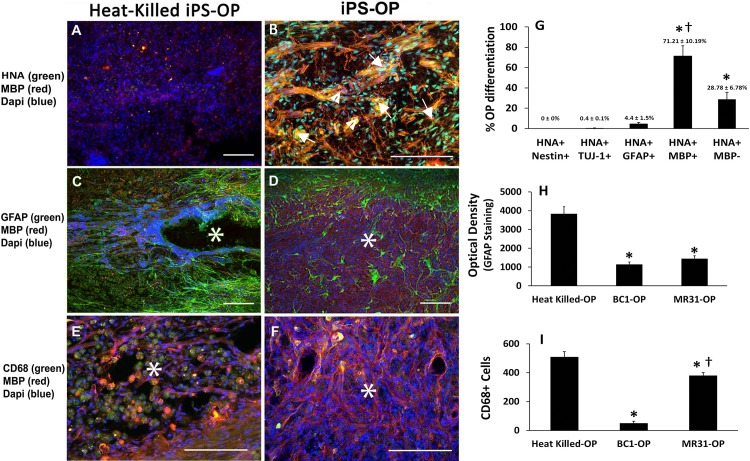
Immunohistological characterization in rat spinal cords at the epicenter of injury (asterisks) following transplantation of either (A) heat-killed iPS-OPs or (B) live iPS-OPs, 24 hours after injury.Human specific anti-nuclei antibody (HNA) staining showed that cells transplanted at the site of injury could survive, differentiate and express myelin basic protein (MBP, red) in iPS-OPs group, compared to the heat-killed iPS-OPs group. (C) Heat-killed iPS-OPs treated spinal cords demonstrated more cavitation and higher glial fibrillary acidic protein (GFAP) (green) expression than (D) spinal cords treated with iPS-OPs. Heat-killed iPS-OPs also expressed less MBP, a mature oligodendrocyte marker, than live iPS-OPs (red). (E) Double immunostaining with CD68 (expressed by macrophages, microglial, and T cells) and MBP shows more CD68+/MBP+ cells in control animals with morphology indicative of active macrophages or microglial engulfment of OPs. (F) Spinal cords injected with iPS-OPs had significantly fewer CD68+/MBP+ cells. Tissues shown here were isolated approximately 2 months after transplantation. DAPI was used to stain rat and human nuclei (blue). Scale bars for A, C, D: 100 μm and B, E, F: 30 μm. (G) Quantitative image analysis shows that more than 70% of HNA+ cells were differentiated MBP+ oligodendrocytes. Only 4.4 ± 1.5% of grafted cells express glial fibrillary acidic protein (GFAP), while no HNA+ cells were detected with co-localized staining for neuronal marker neuron-specific class III beta-tubulin (TUJ1) or NESTIN. Values represent mean ± SEM. * denote statistical significance of human MBP+ oligodendrocytes and MBP- OPs compared to either human-derived neural progenitors (Nestin+), neurons (TUJ1+) or astrocytes (GFAP+) and † denotes statistical significance of human HNA+MBP+ compared to HNA+MBP- OPs by Tukey post hoc tests. Tissue slices encompassing the injury epicenter were stained in intervals for each antibody combination from 4 rats in each treatment group, P < 0.001). (H) Optical density quantification of GFAP staining, which shows significantly higher intensity of GFAP staining in heat-killed iPS-OP compared with iPS-OPs of both BC1 and MR31 lines. (I) Quantification of the number of CD68+ cells shows significantly higher CD68+ cells in heat-killed iPS-OPs, indicative of increased inflammation and macrophage activation, compared with iPS-OPs of both BC1 and MR31 lines. Values in the graphs represent mean ± SEM. * and † denote statistical significance compared to heat-killed iPS-OPs and BC1-OPs, respectively by Tukey post hoc tests (10 identically numbered tissue slices encompassing the injury epicenter from 4 rats were analyzed for each treatment group, P < 0.001).